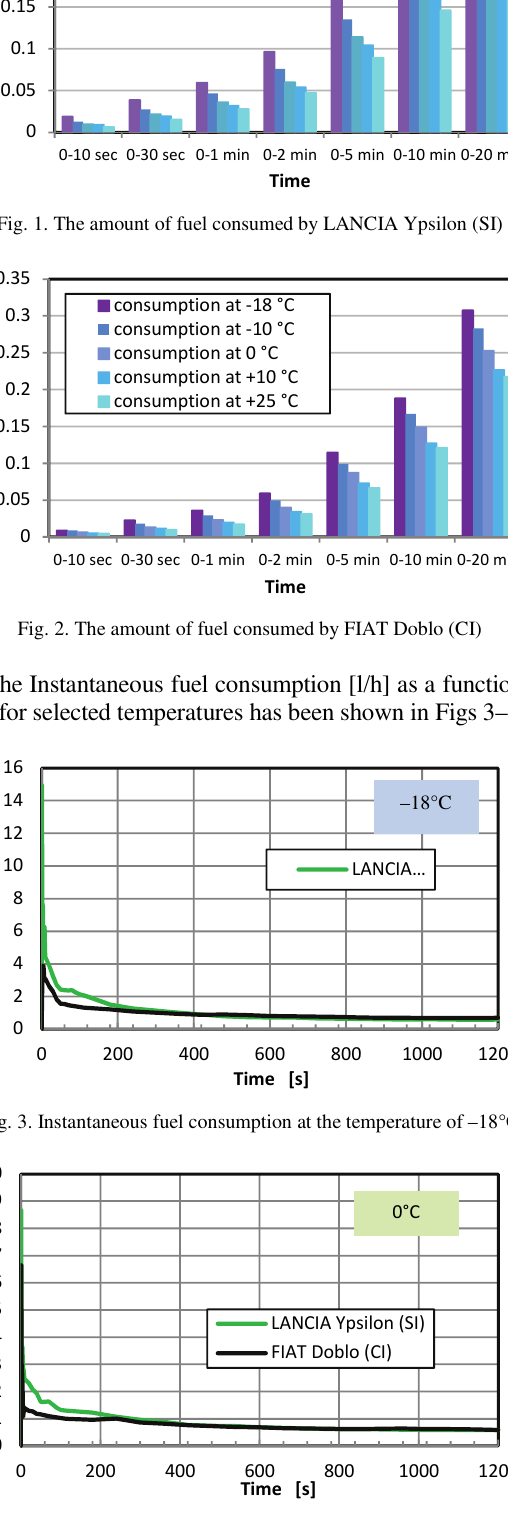
Fig. 4. Instantaneous fuel consumption at the temperature of